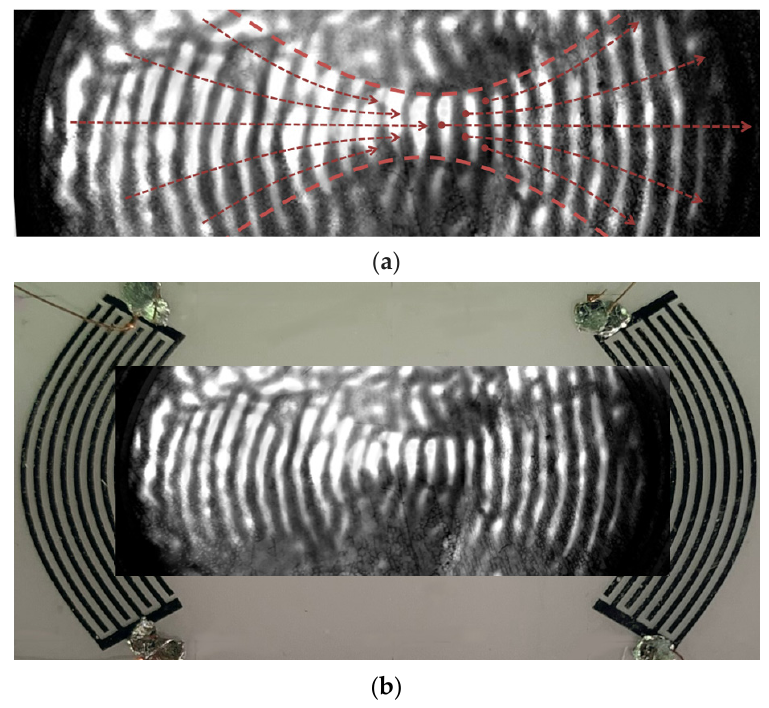
Figure 8. ( a ) Electric field of the SH 0 wave on the surface of YX LiNbO 3 plate visualized with an electron microscope and ( b ) optical photo of the delay line combined with the field image meas- ured using the SEM